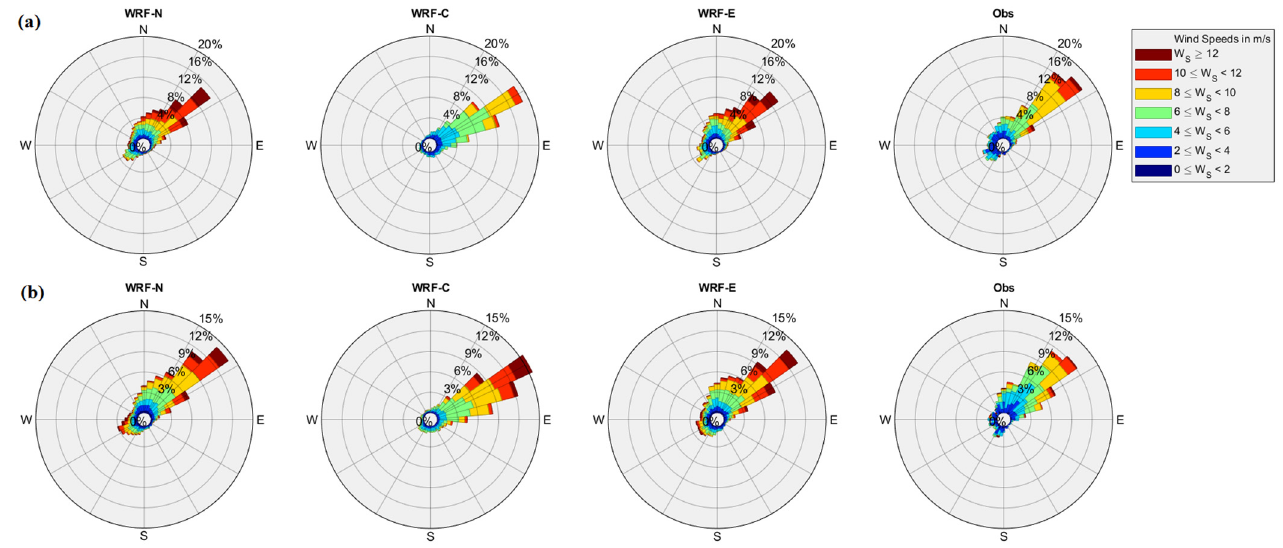
Figure A8. Wind rose diagram on an hourly timescale from the models and observations for the years ( a ) 2017 (top) and ( b ) 2018 (bottom) at Hong Kong.